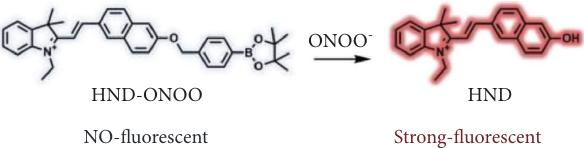
Scheme 1: Te molecular structures of HND-ONOO and response mechanism to ONOO −